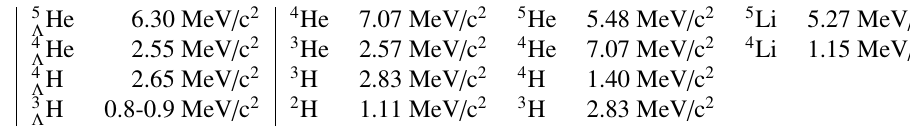
Table 2. Hypernuclei behave similarly to ordinary nuclei with respect to the binding energy per